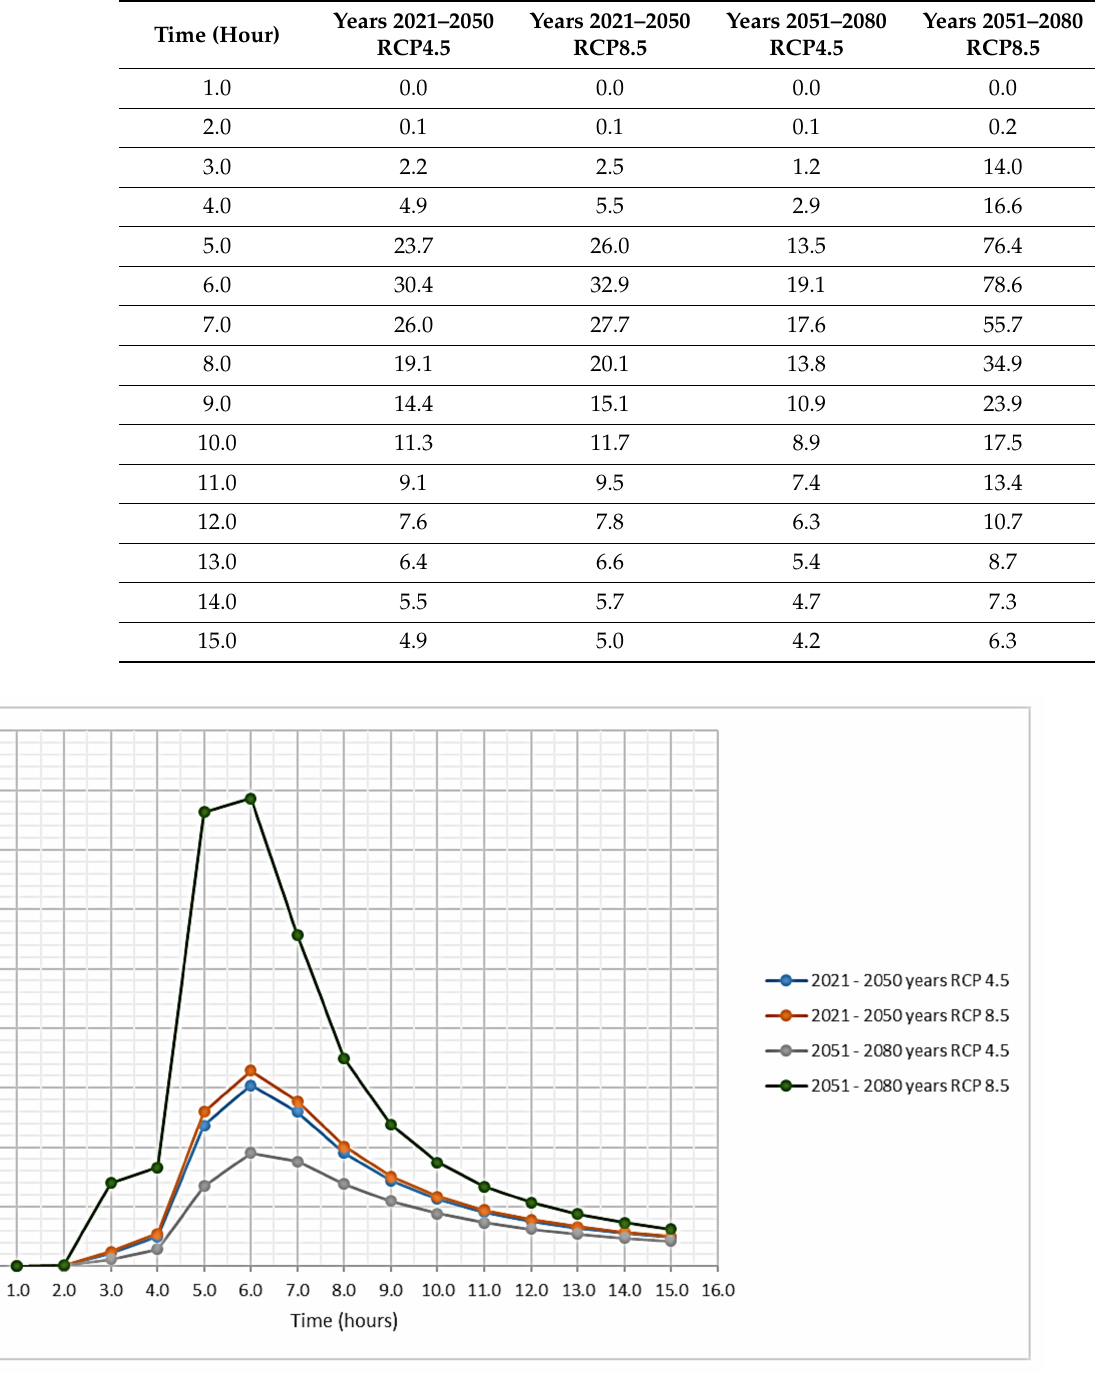
Figure 37. Flood hydrographs for RCP4.5 and RCP8.5 scenarios for 2021–2050 and 2051–2080